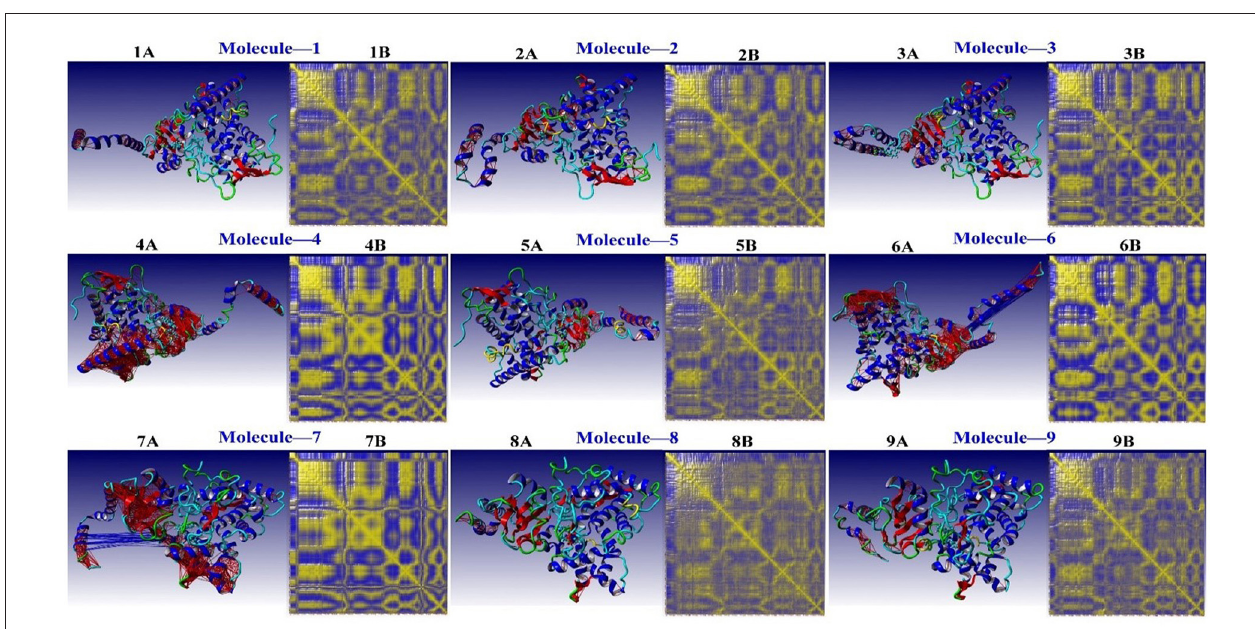
FIGURE 7 | The residual correlative motion in protein structures was visualized by the dynamic cross-correlation map analysis for CYP51 [Blue and Red lines are shown between strongly, anti- and correlated pairs, and DCCM is visualized with colors ranging from blue ( − 1, fully anti-correlated) to yellow ( + 1, fully correlated)].